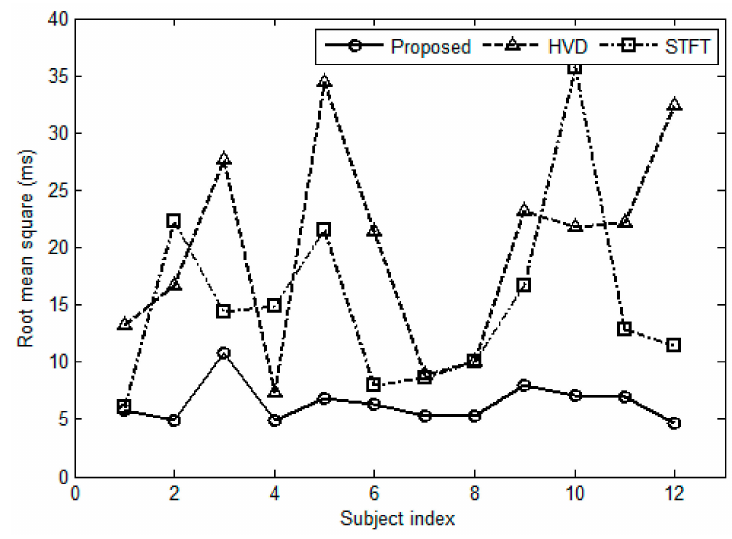
Figure 14. Performance comparison among the three methods in term of RMS. Table 2. The confidence intervals of mean and standard deviation in 95% confidence